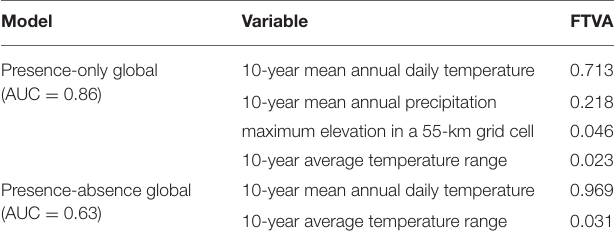
Presence-absence global (AUC = 0.63)